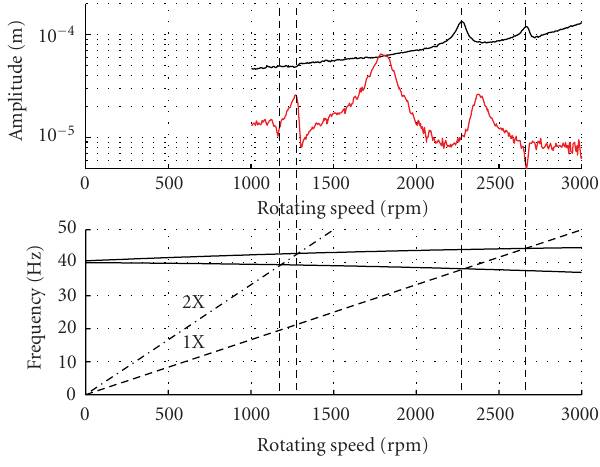
Figure 5: Unbalance response (black line = 1st order, red line = 2nd order) and Campbell diagram at the plane location A3.